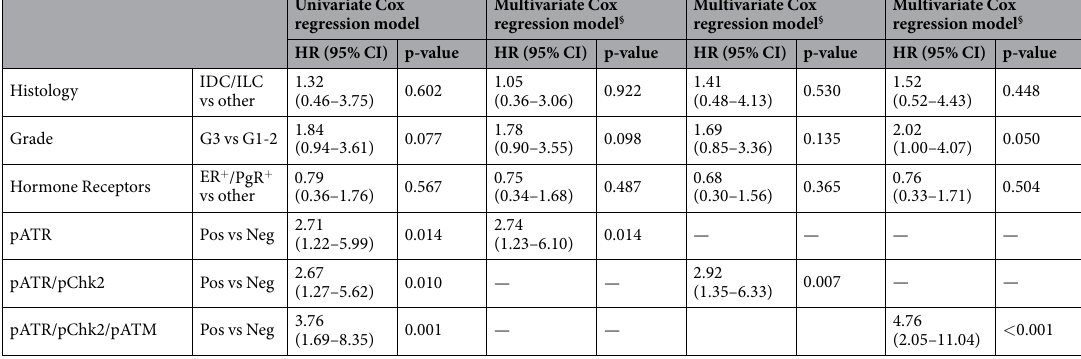
Table 2. Univariate and multivariate Cox regression models for 10-year survival (N = 112). § Adjusted for : Histology, Grade, Hormone Receptor Status.